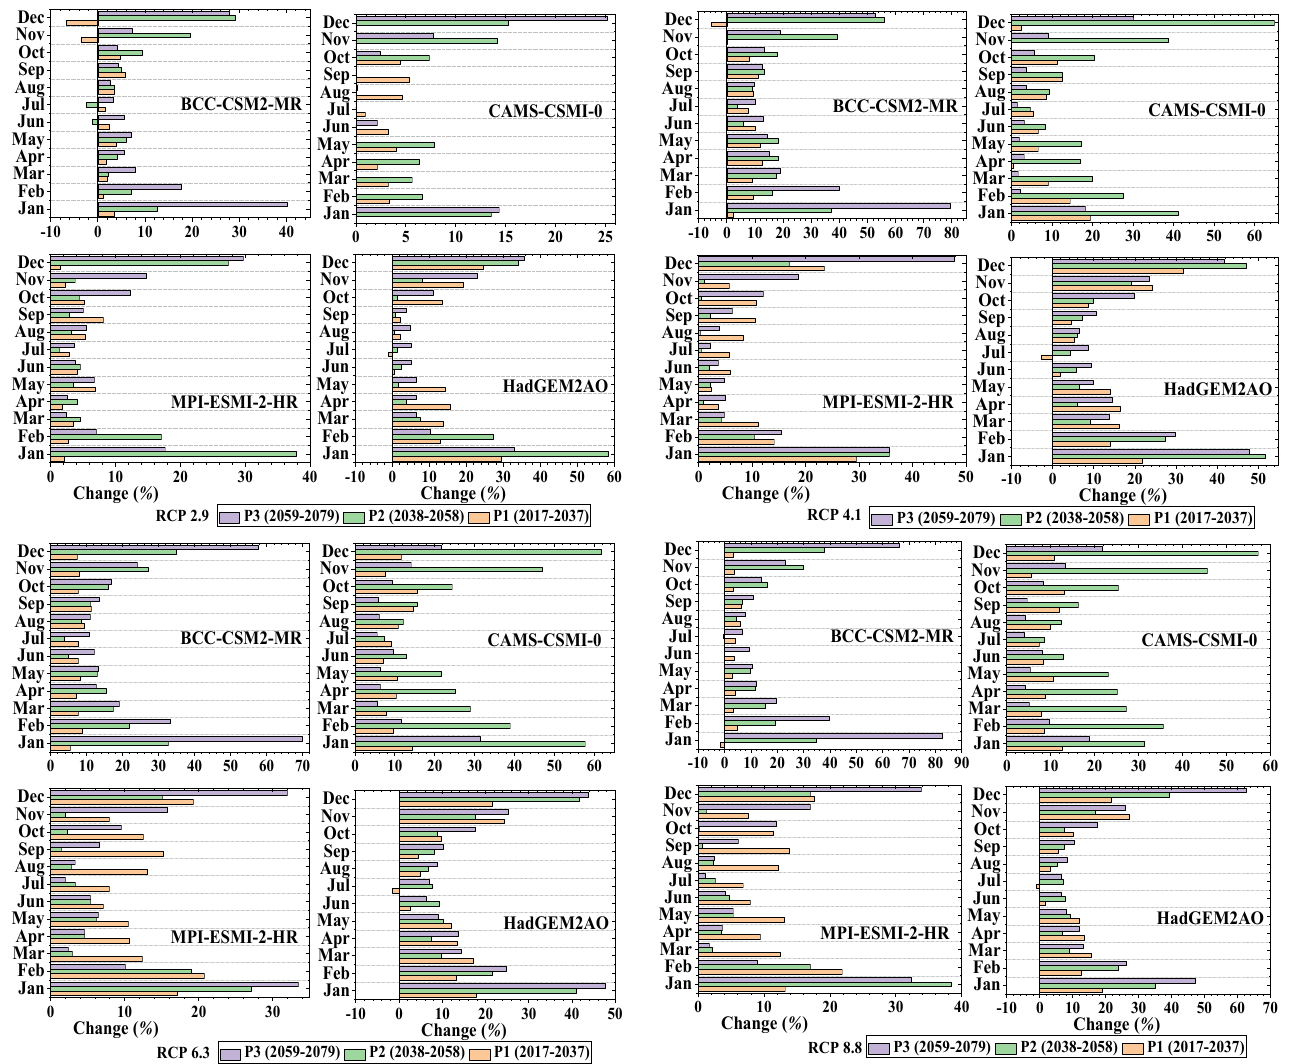
Figure 8. Projected climatology of changes in evapotranspiration (%) depicted by the deployed GCMs in the AR5-based emission scenarios.